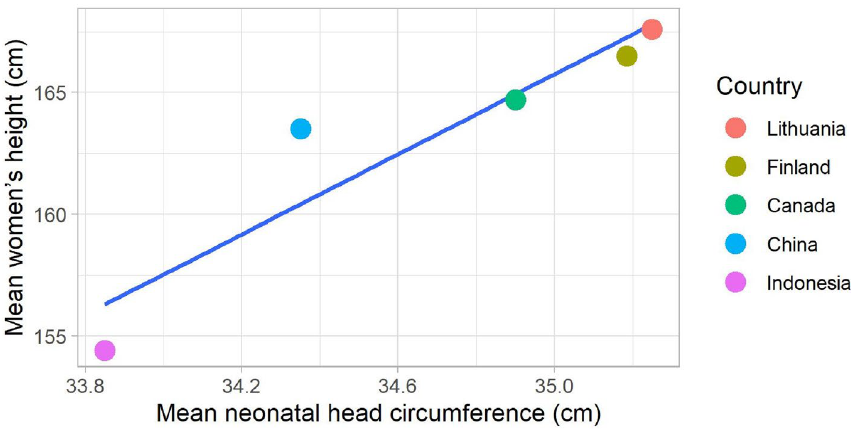
Figure 3. Neonatal head circumference (cm) at term (40 weeks gestation) in relation to average women’s height across countries 26–29,37